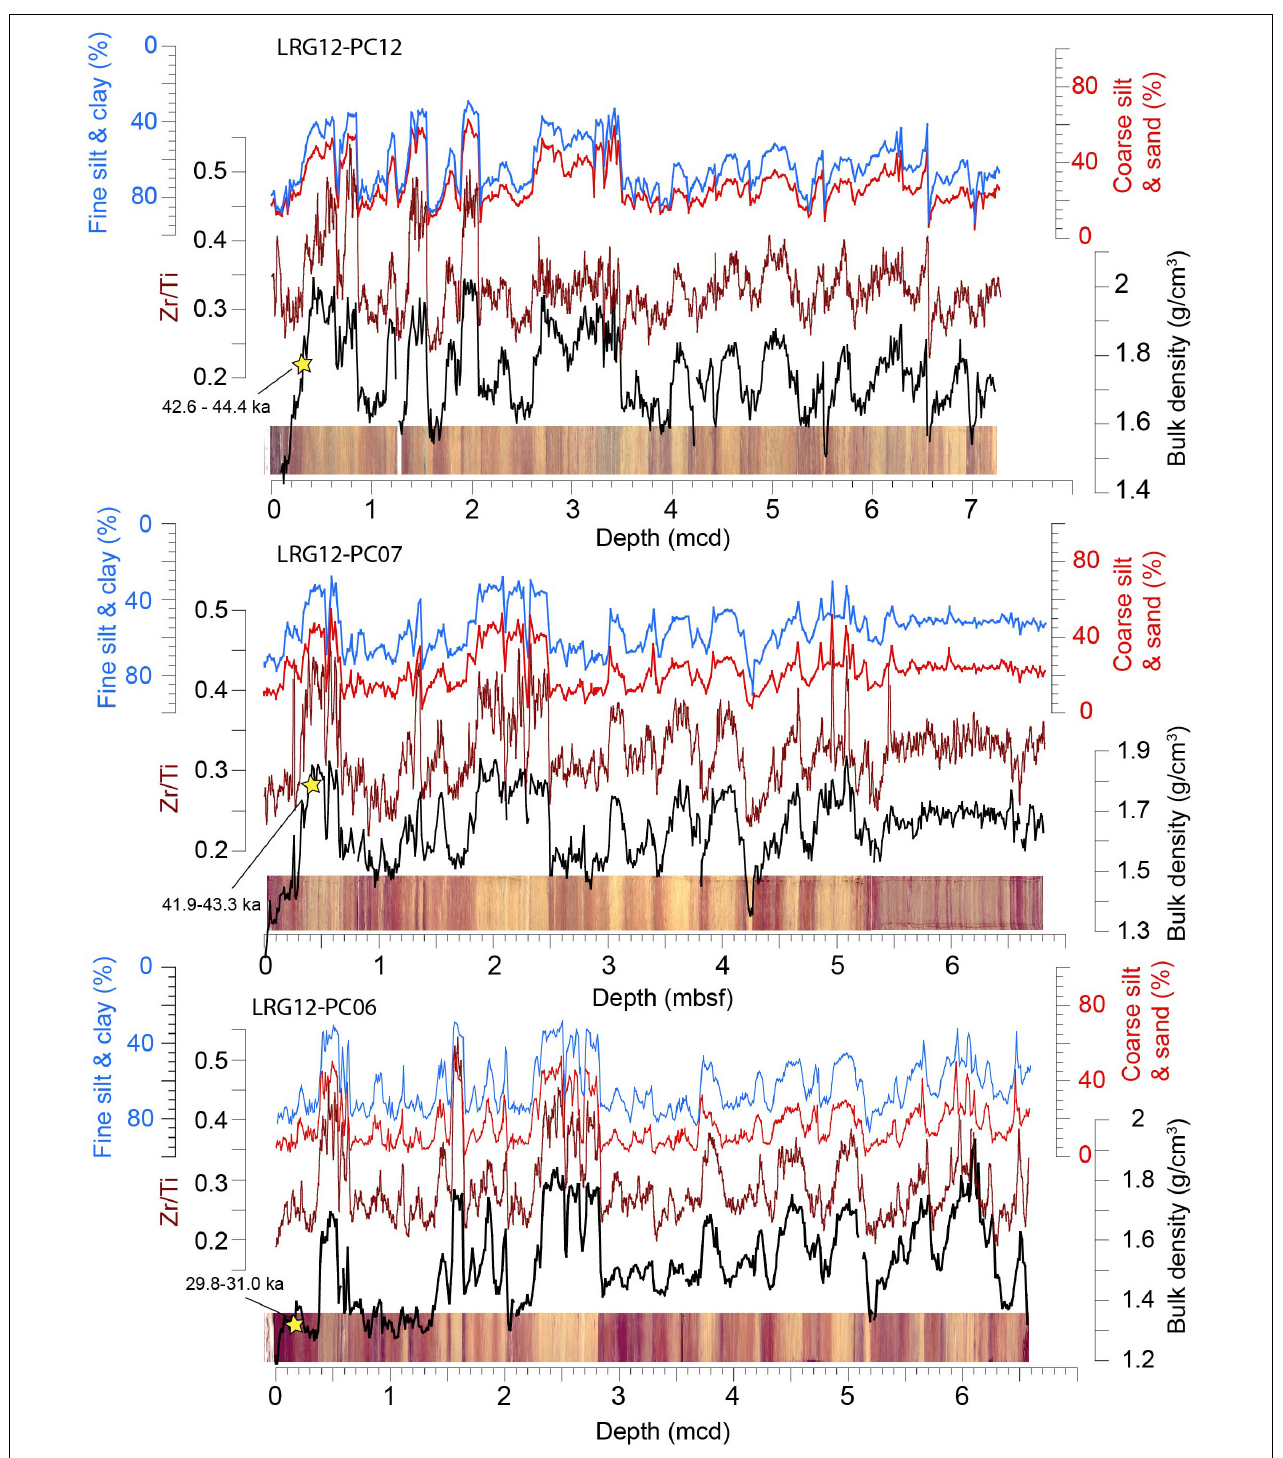
FIGURE 4 | Downhole core records of bulk density, Zr/Ti, and grain size for three records from the Lomonosov Ridge. Grain size data is presented as the % volume of different size fractions. A high degree of correlation exists between all these parameters – supporting the use of bulk density or Zr/Ti as proxies for bulk grain size. The 2-sigma ranges of the oldest finite radiocarbon dates for each core are shown (yellow star). A complete list of radiocarbon dates for each core is given in Table 2 . Core depths are reported in either meters beneath the seafloor (mbsf) or meters composite depth (mcd).